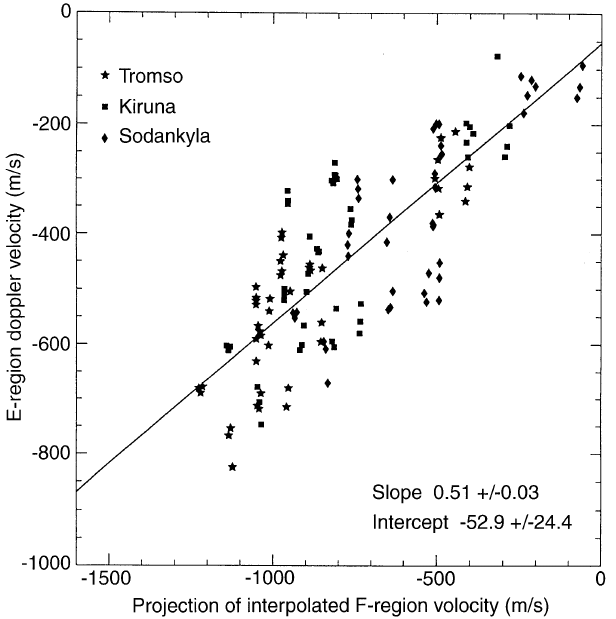
Fig. 7. Comparison of measured LOS velocity to the projected component of the F-region velocity at all three sites. Stars , squares and diamonds are used to for Troms (cid:249) , Kiruna and Sodankyla¨ respec- tively. The solid line is a least squares fit to all the data; slope, intercept, and uncertainties are given in the lower right